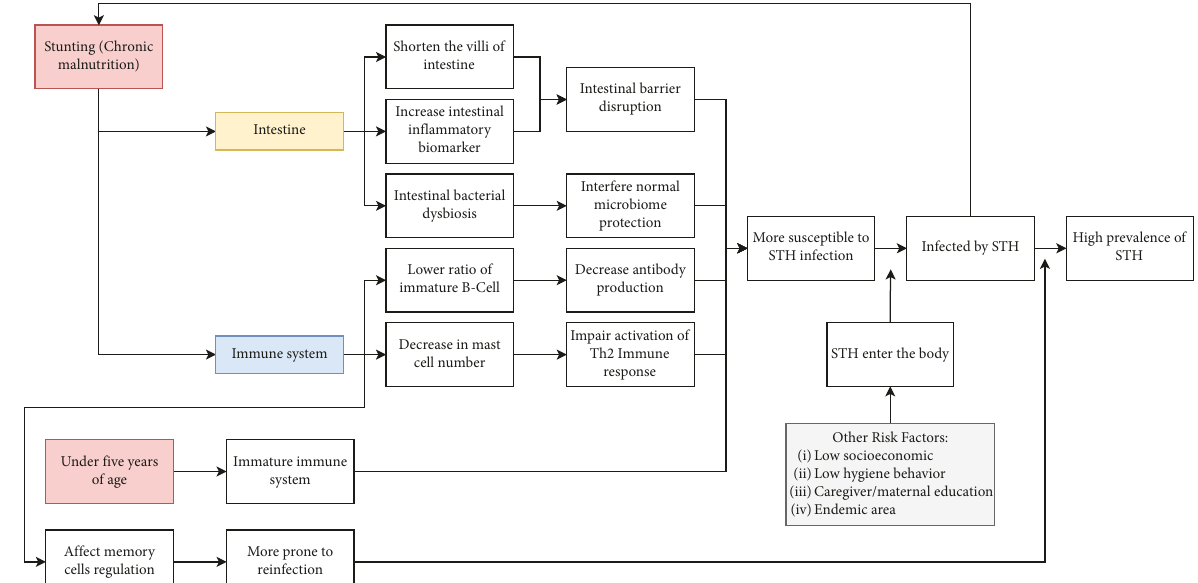
Figure 3: Summary of the possible mechanisms of stunting and under five years of age as a risk factor of STH infection (and reinfection), and other risk factors facilitating the increase of susceptibility of STH